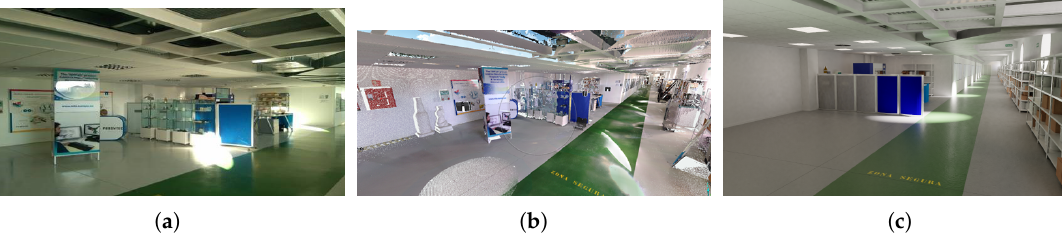
Figure 7. From the real to the virtual environment: ( a ) real environment, ( b ) 3D point cloud, and ( c ) virtual environment.